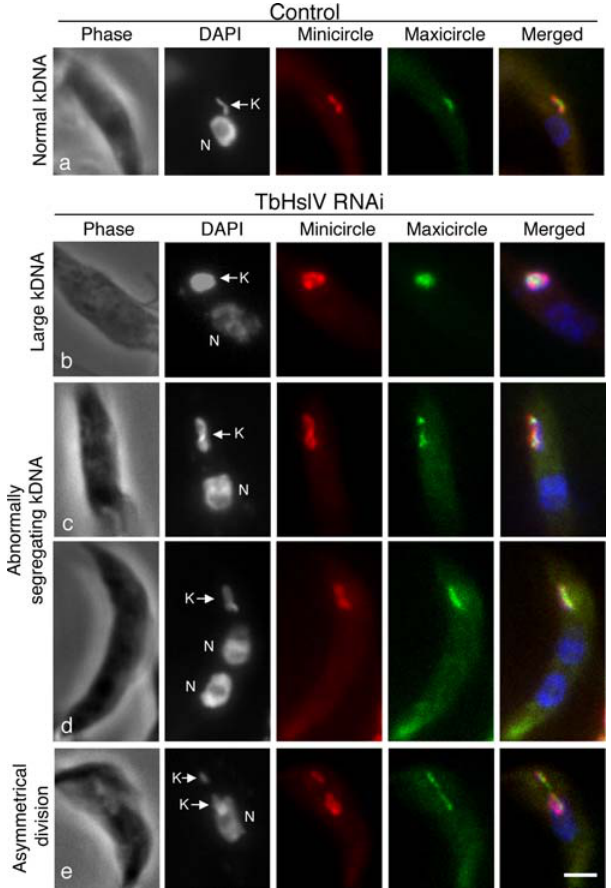
Figure 7. Insitu detection of minicircles and maxicircles in the kinetoplast by FISH. Cells were fixed, probed for minicircles (red) or maxicircles (green), and counterstained with DAPI. kDNA is indicated with a K and nucleus with an N. Bar: 2 m m. FISH does not detect covalently-closed DNA minicircles because they are non-denaturable [24]. This is likely also true for maxicircles. Thus the FISH signal may not be proportional to the total populations of minicircles and maxicircles. Bars: 2 m